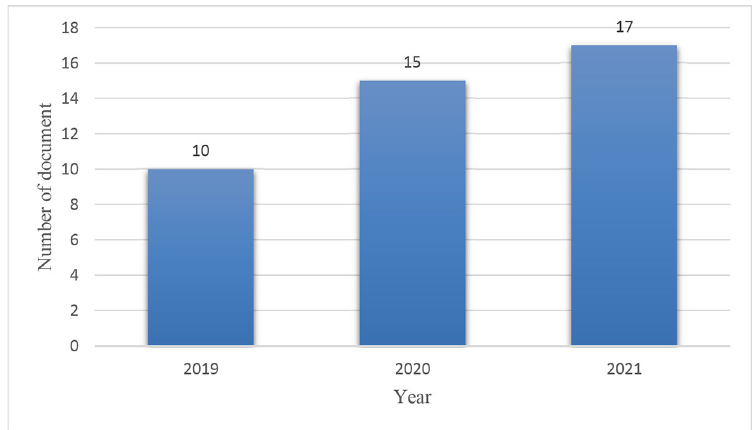
Figure 4. Year-wise distribution of the